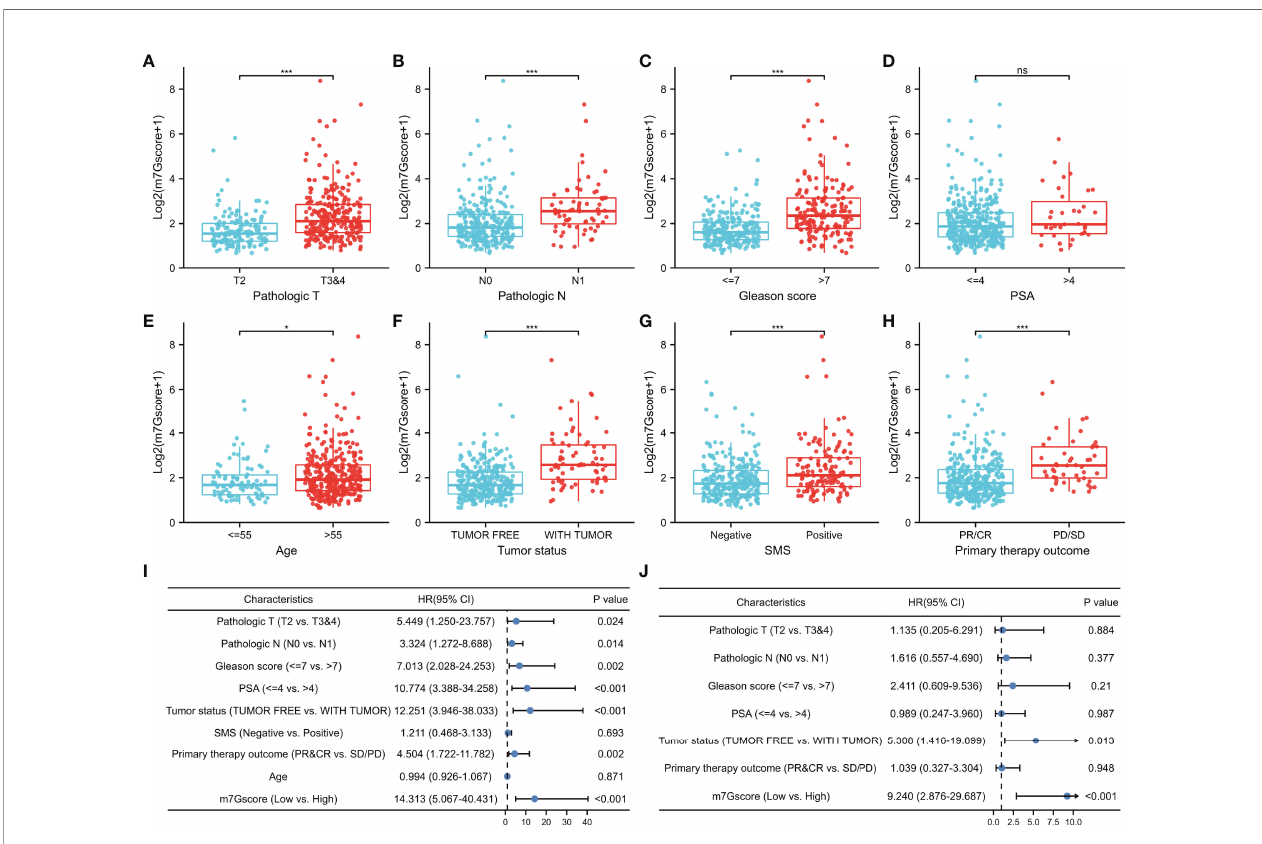
FIGURE 5 | Association between m7Gscore and clinicopathological factors. (A – H) The distribution of m7Gscores according to pathological T stage (A) , N stage (B) , Gleason score (C) , PSA ( D ), age (E) , tumor status (F) , SMS (G) , and primary therapy outcome (H). (I, J) Veri fi cation of the characteristics of m7Gscore to be an independent BCR-free prognostic index with the univariate (I) and multivariate (J) Cox regression analyses. PSA, prostate-speci fi c antigen; SMS, surgical margin status; BCR, biochemical recurrence. *p < 0.05; ***p < 0.001. ns, no signi fi